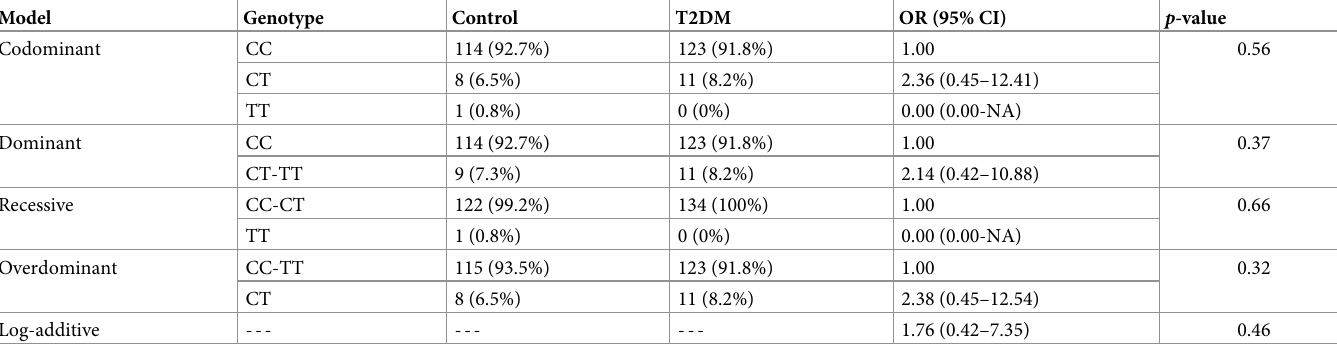
Table 4. Polymorphism rs1527483 association with response diabetes based on "SNPStats" analysis tool. Model